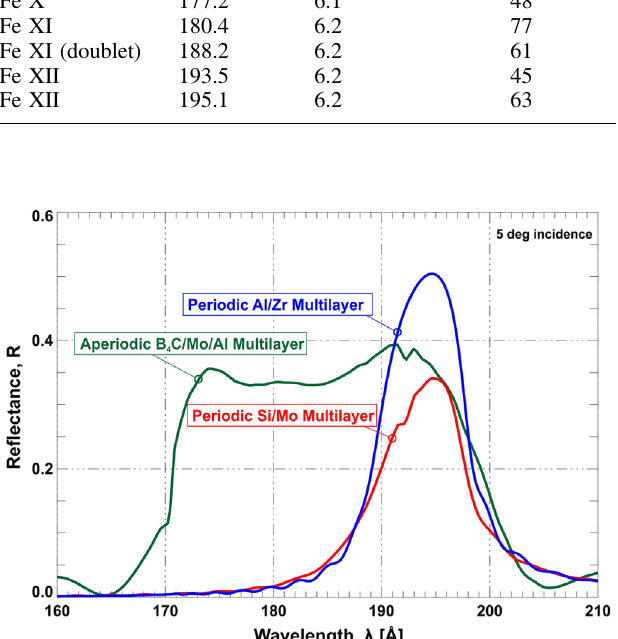
Fig. 6. Calculated re fl ectance near normal incidence (5) of the broad-band, aperiodic B 4 C/Mo/Al multilayers used for the SunCET telescope mirrors (green), and for reference, the narrow-band, periodic Si/Mo multilayer coatings used for the GOES/SUVI instrument (red), and the Al/Zr multilayer coatings used for the Hi-C rocket instrument